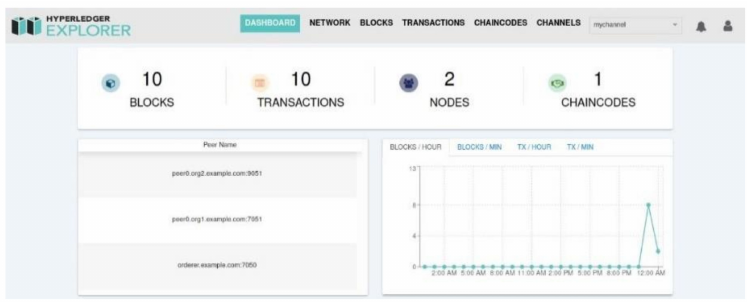
Figure 11. Monitoring screen of the established blockchain-based